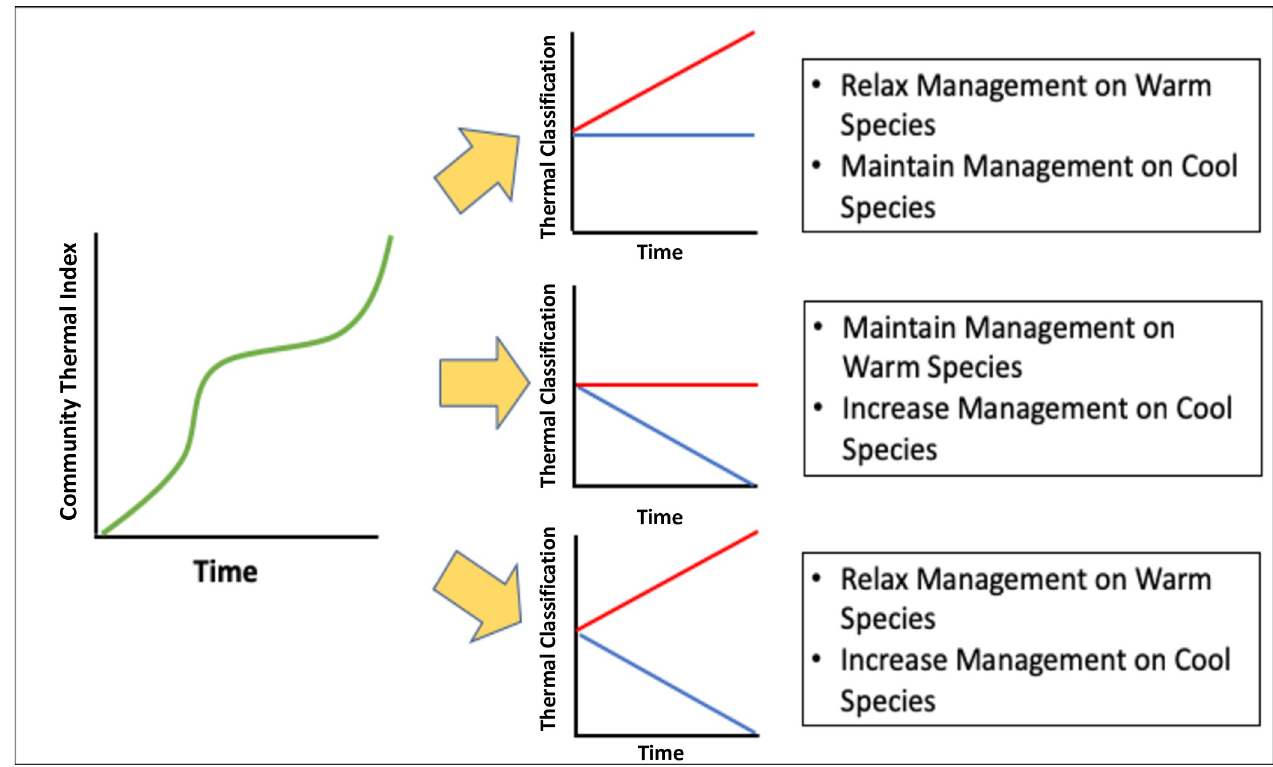
Fig 3. Comparisons between CTI and our multi-data source, thermal classification scheme. The single trend line for Community Thermal Index (CTI) obscures the responses of specific groups of species to environmental drivers challenging management decision-making. The Y-axis on each of these graphs would represent some indicator of ecosystem change such as density or biomass. Because CTI is a single trend line, it masks the potentially different contributions of species or species groups to the trend. For example, the three scenarios on the right could all result from the single CTI trend shown on the left. The additional resolution offered by thermal classification gives managers finer scale information to enact specific actions that either benefit or boost populations at risk (e.g., decreased fisheries take, restoration action, marine protected) or increase resource use on populations experiencing increases (e.g., increased fisheries take, species